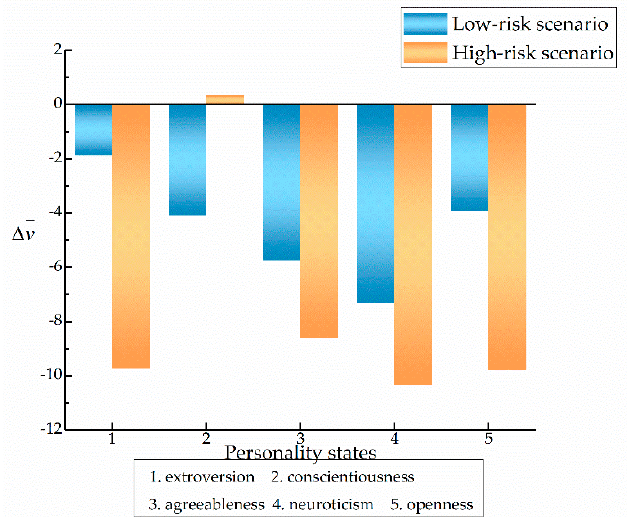
Figure 8. Comparison of v Δ for the five types of personality in risky scenarios.